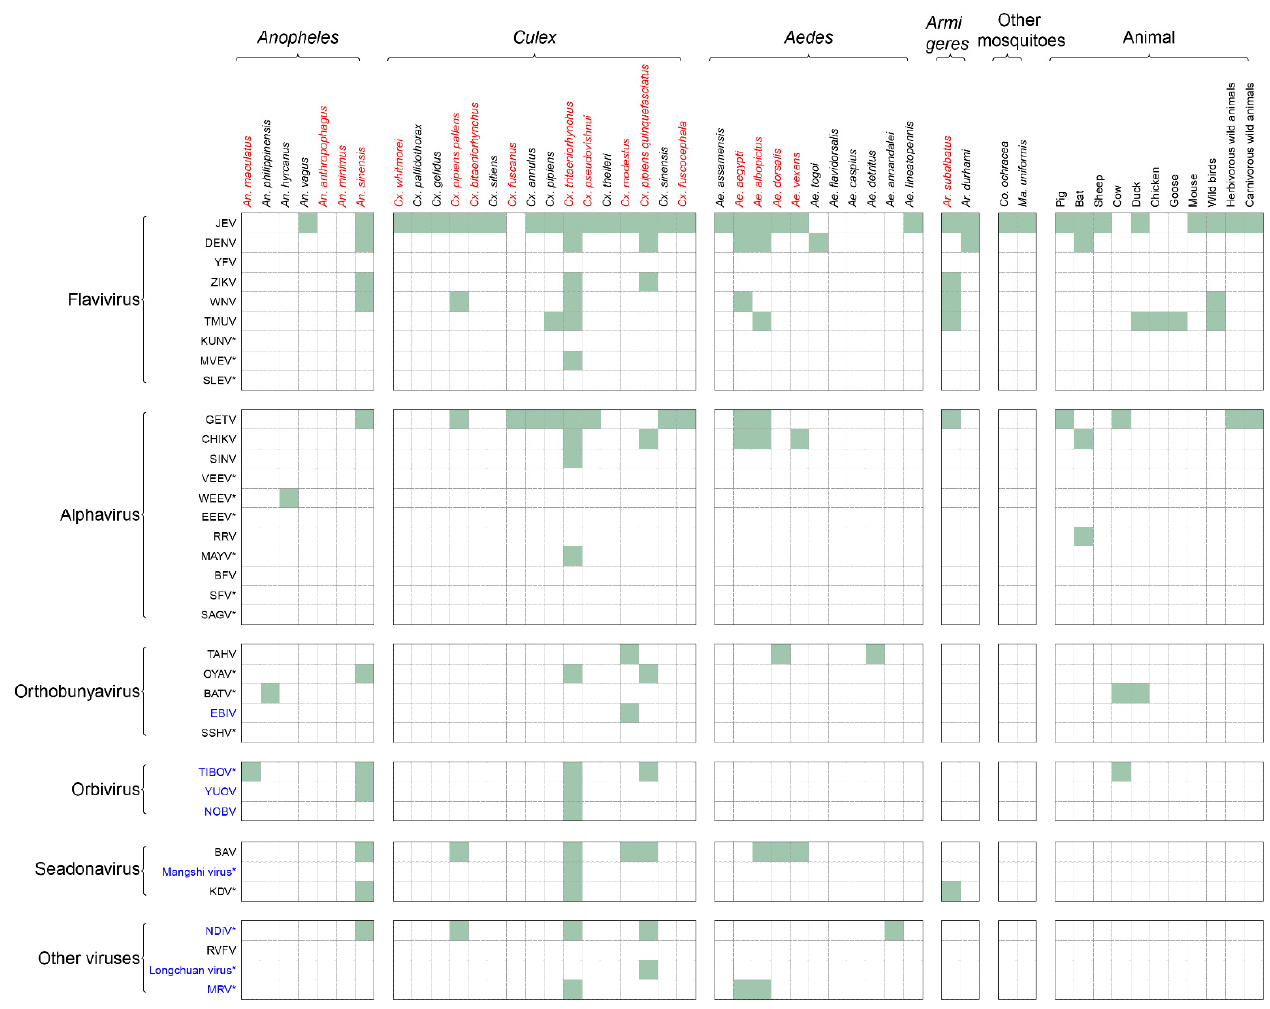
Figure 2. Mosquito species and animals for mosquito-borne viruses in China from 1954 to 2020. The virus names colored in blue indicate newly identified pathogens in the past two decades in China. “*” indicates arboviruses that have never been reported in human cases in China, but with the detection of viruses in mosquitoes or animals, or the detection of IgG in people. The mosquito names colored in red indicate species included in ecological models.